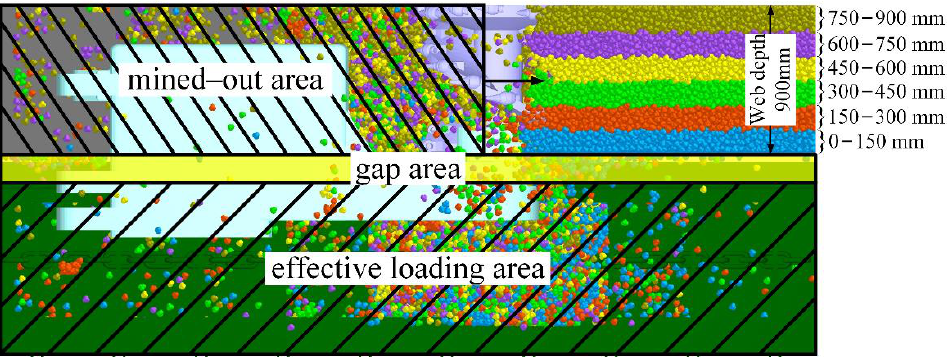
Figure 8. Division of statistical zone from top view of mining face.